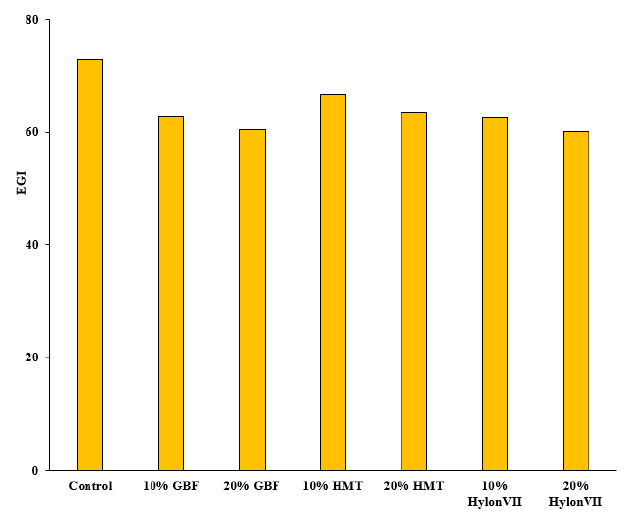
Figure 2. Effect of different proportions of resistant starch sources on the estimated glycemic index (EGI) of salted noodles.